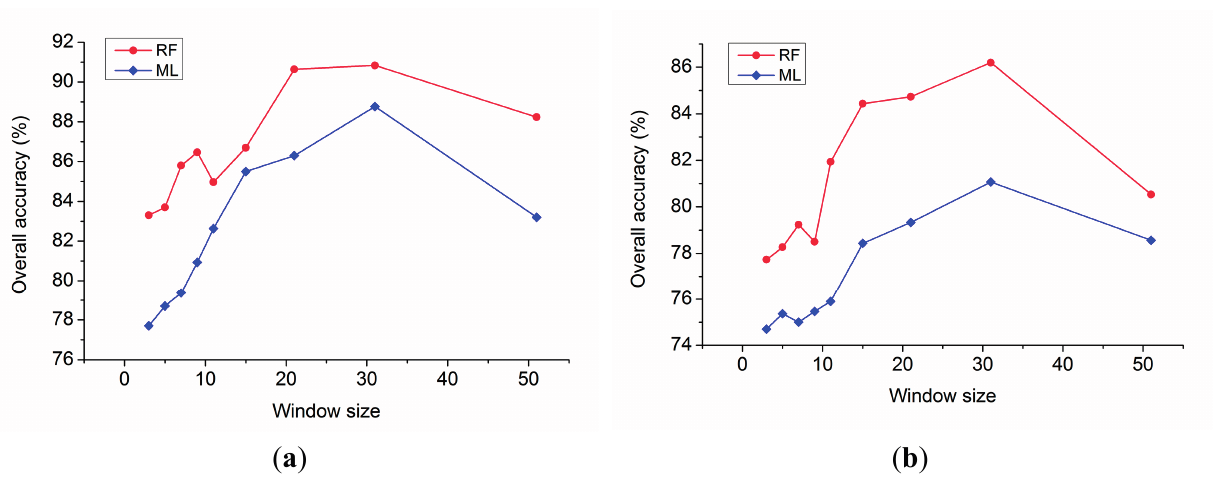
Figure 11. Accuracy comparison between Random Forest and Maximum